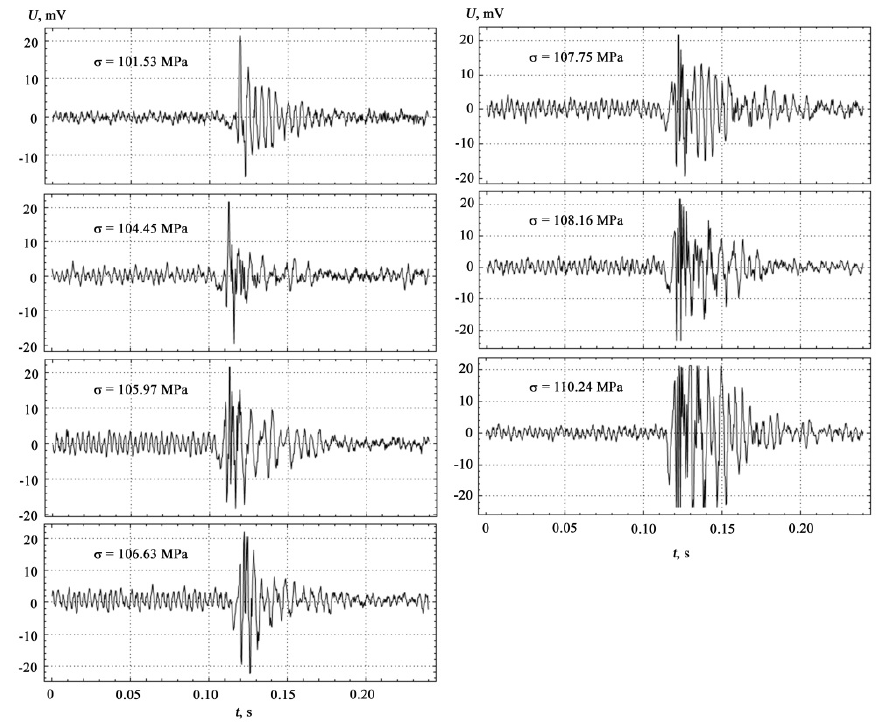
base of ST3sp steel are shown in Figure 5. Figure 4. Results of AE measurements for the ED-20 polymer matrix.